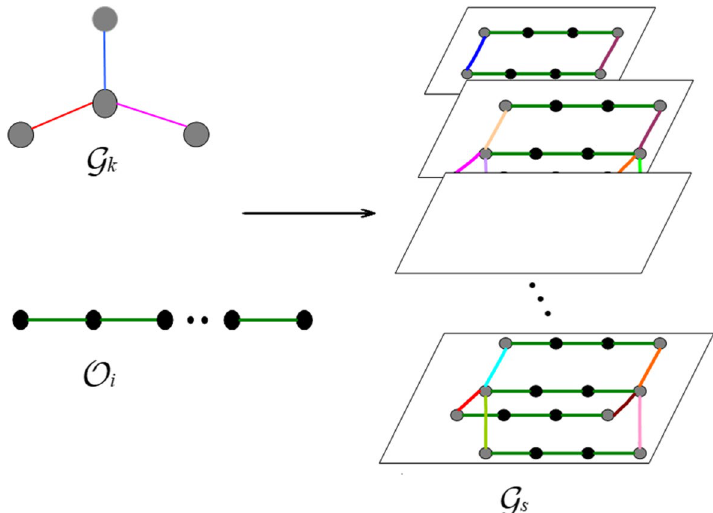
Fig. 1 The visualization of the multiple graphs G